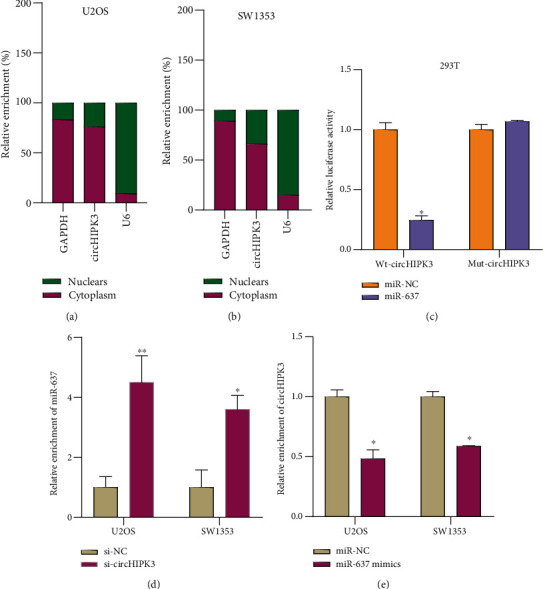
circHIPK3 served as a sponge for miR-637. (a, b) Comparison of the abundance of circHIPK3 in nuclear and cytoplasmic. (c) Luciferase reporter assay showed that miR-637 mimics dramatically reduced luciferase activity of the Wt-circHIPK3 group. (d) miR-637 was enriched by the downregulation of circHIPK3 compared with the negative control. (e) Compared with the control group, miR-637 overexpression downregulated circHIPK3. ∗p < 0.05 and ∗∗p < 0.01.